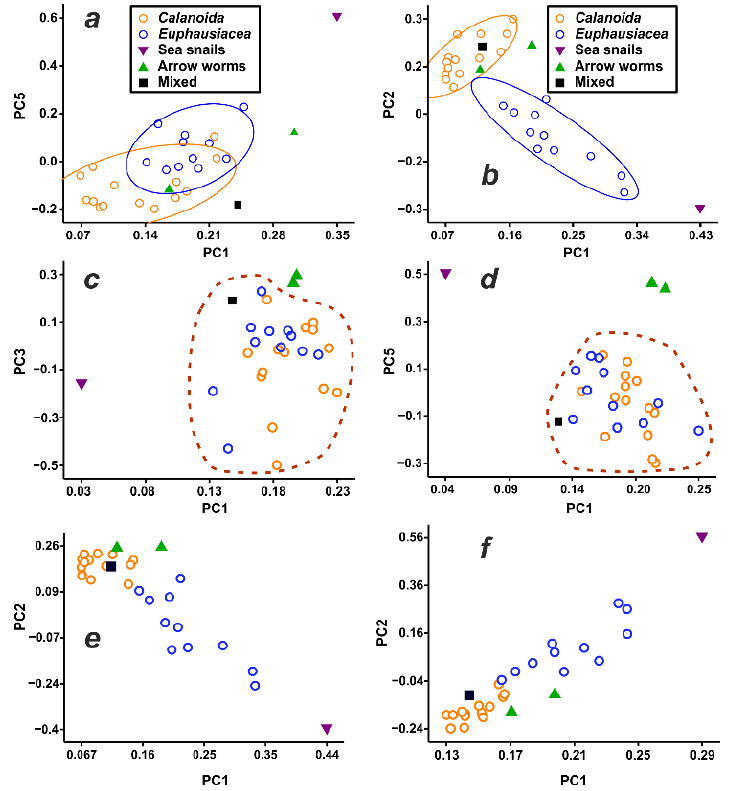
Figure 2. Score graphs for the PCA decompositions of LIBS ( a , b ) and Raman ( c , d ) spectra before ( a , c ) and after ( b , d ) masking the strongest signals. Dashed lines enclose the crustacean samples; ( e ) LIBS spectra without Li signals; ( f ) SUM-PCA for LIBS + Raman data without Li signals. In ( a , b ), confidence ellipses ( p = 0.95) for the respective clusters are shown.